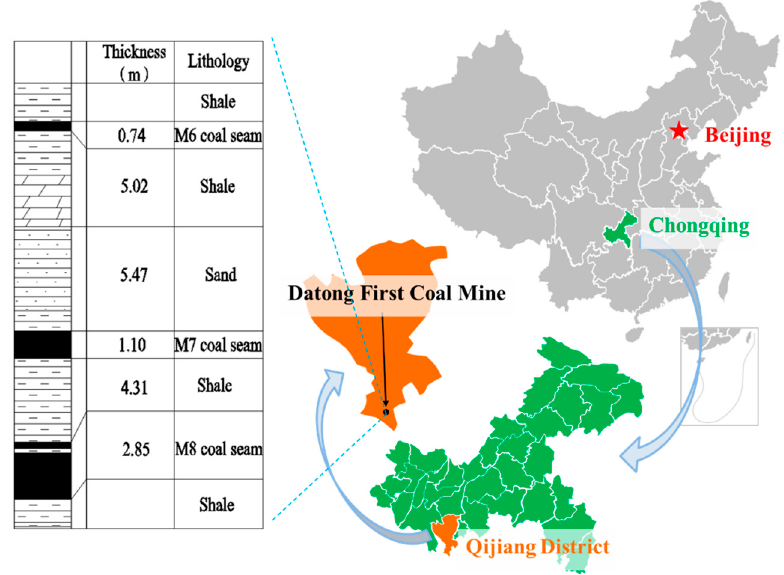
Figure 4. Location of the Datong First Coal Mine.